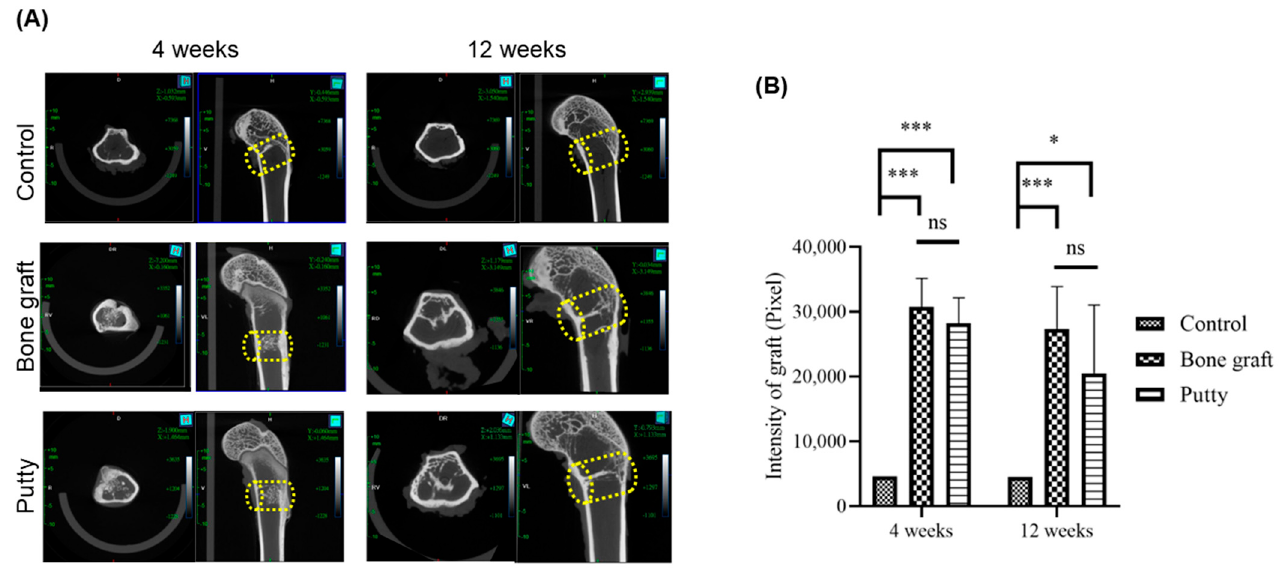
Figure 5. Computed tomography ( μ -CT) assessment of the critical-sized bone defects. ( A ) Repre- sentative transverse and coronal CT images. ( B ) μ -CT signal quantification of resorption of the bone graft and putty after implantation. The yellow cylinder indicates the defect site. The significance was set at ns- ( p > 0.05), *—( p < 0.05), ***—( p < 0.0001).